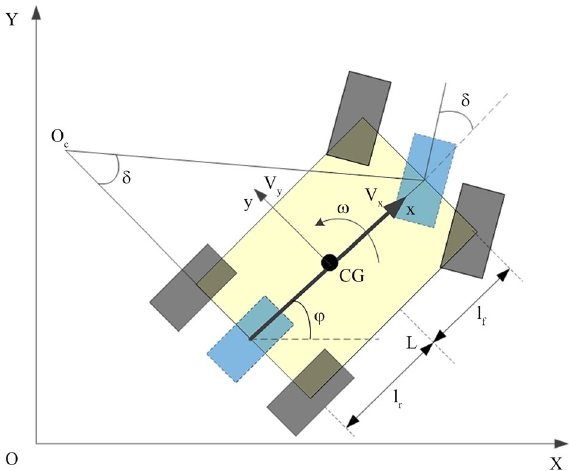
Figure 2. Two-degrees-of-freedom kinematics model (blue) at the